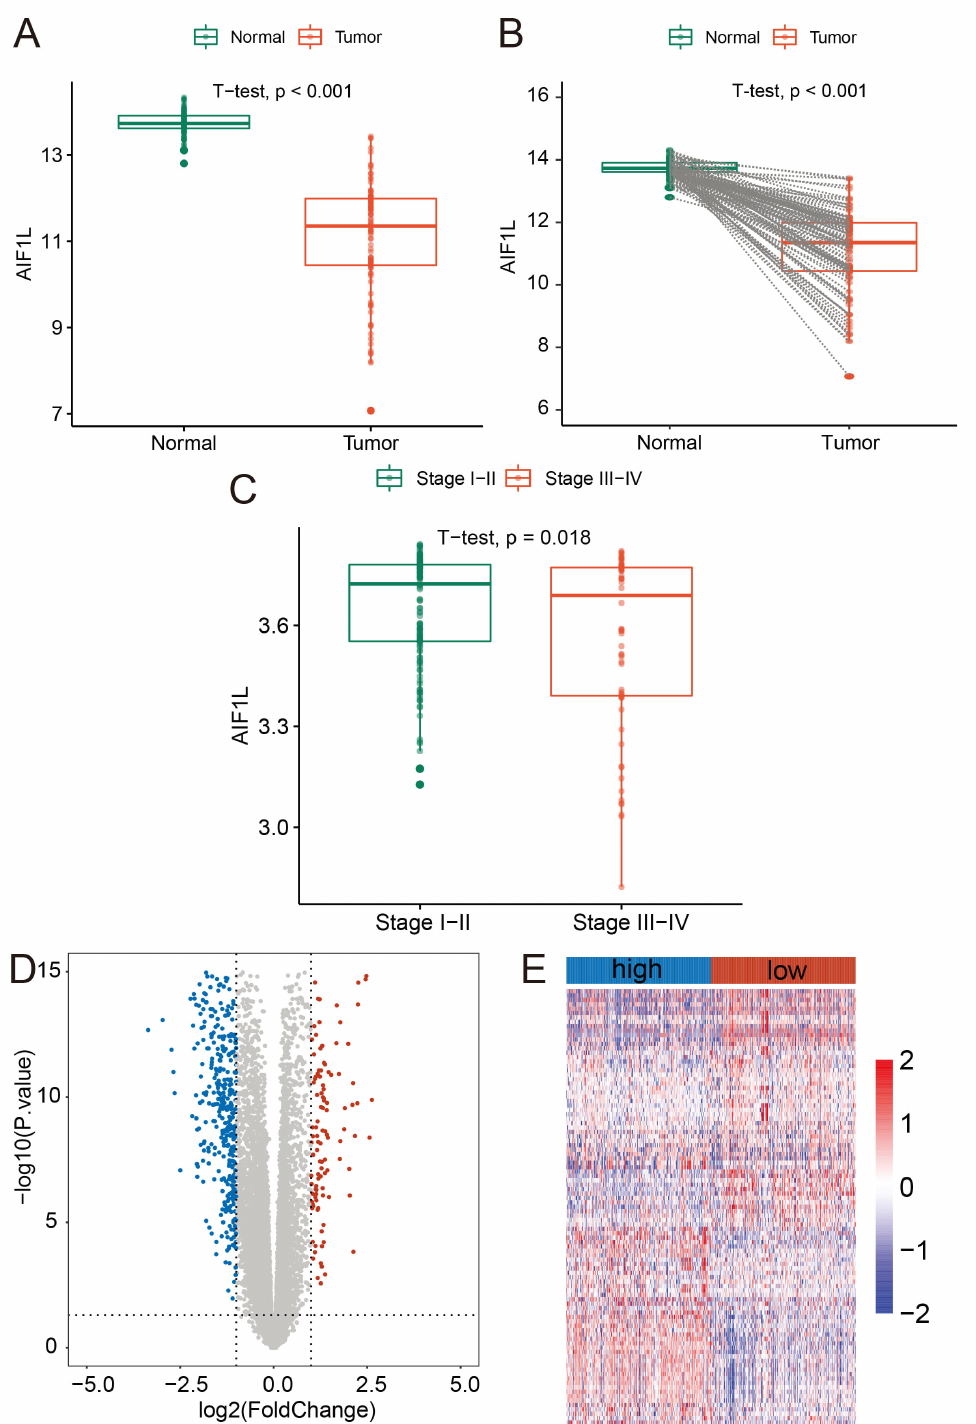
Fig. 2. Validation in an independent dataset and DEG analysis. (A) Students t -test result for AIF1L expression between ccRCC and normal kidney samples. (B) Paired t -test result for AIF1L expression between paired ccRCC and normal kidney samples. (C) Students t -test result for AIF1L expression in Stage I–II and Stage III–IV samples. (D) Volcano plot visualizing the DEGs. The data for 539 ccRCC samples and 72 corresponding healthy kidney samples was extracted from the TCGA datase. The vertical lines demarcate the log2 fold- change values, while the horizontal line marks a –log10 p -value of 0.05. Red represents the upregulated genes, while blue represents the downregulated genes. (E) Heatmap for the DEGs. The data for 539 ccRCC samples and 72 corresponding healthy kidney samples was extracted from the TCGA datase. The samples were divided into two groups based on the median value for AIF1L expression. Abbreviations: DEG, differently expressed